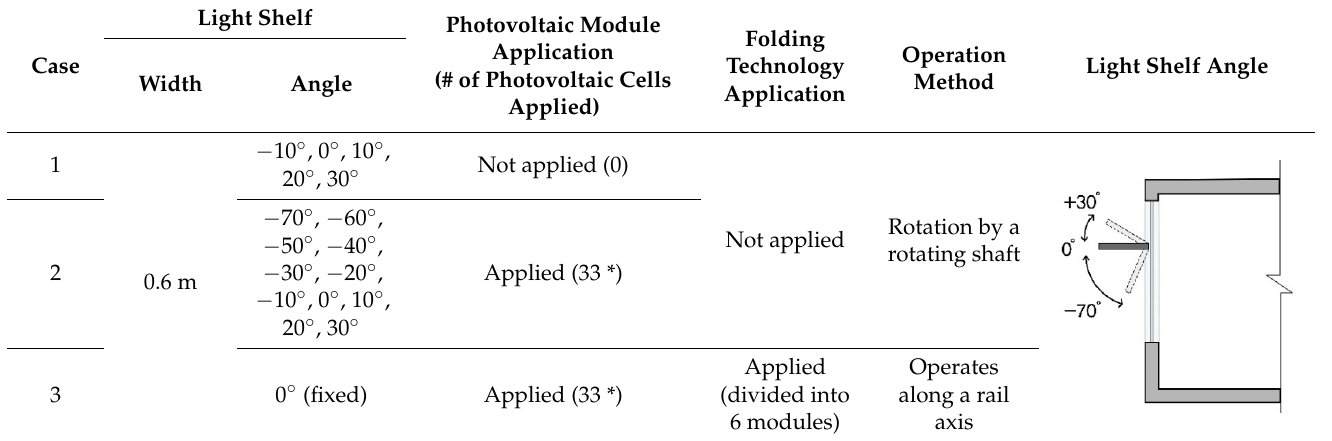
Table 3. Case settings for performance evaluation.